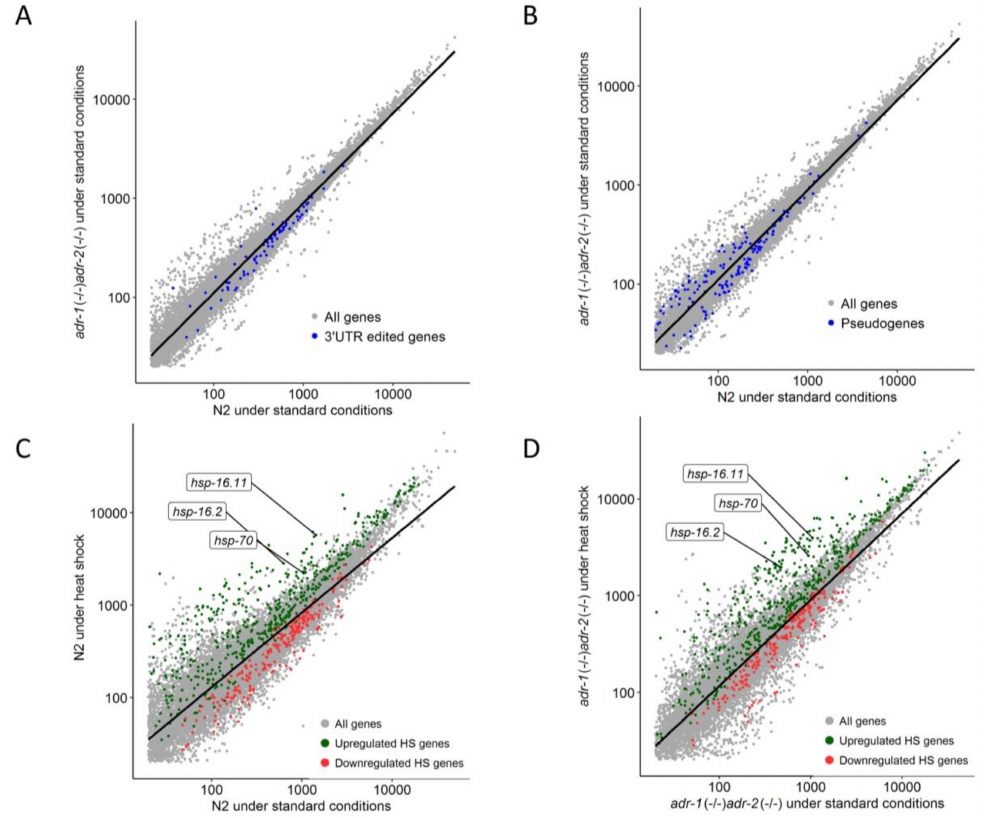
Figure 2. Gene expression changes under standard conditions and upon heat shock. ( A , B ) Log scale plots presenting normalized gene counts of at least three biological samples in adenosine-deaminases (ADAR) mutant worms compared to wild-type (N2) worms, under standard conditions. Grey dots represent all genes (n = 12,059), blue dots represent 3 (cid:48) UTR-edited genes (n = 81) ( A ) and pseudogenes and long non-coding RNAs (lncRNAs) (n = 216) ( B ), and the black line is the regression line for all genes. ( C , D ) Log scale plots representing normalized gene counts of at least three biological samples under heat shock compared to standard conditions, for N2 ( C ) and for ADAR mutant ( D